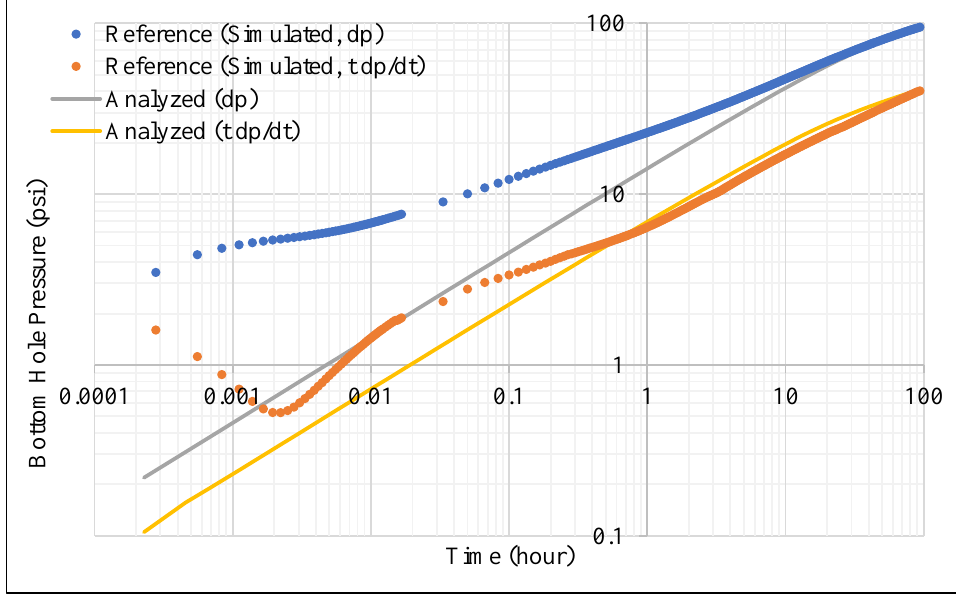
Figure 4. Analysis of build-up test of the reference model in the log – log plot.